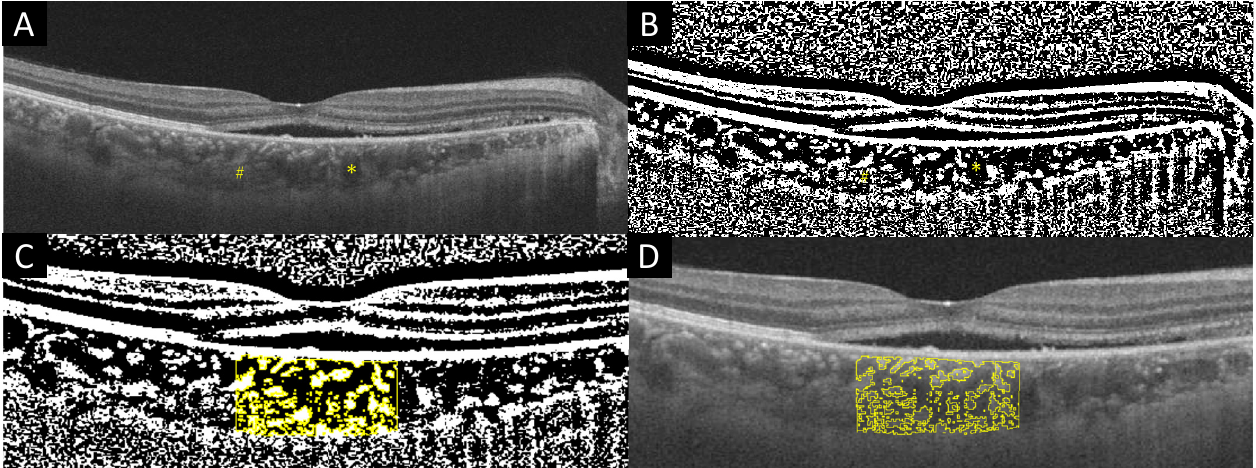
Figure 1. ( A ) OCT image of a preeclampsia patient. The luminal areas (asterisk) and stromal areas (sharp) can be seen. ( B ) Binary image using Niblack method. The luminal areas are darker and the stromal areas are brighter than in ( A ). ( C ) The yellow region is the stromal areas. ( D ) Overlay of the original EDI-OCT image and binarization image.